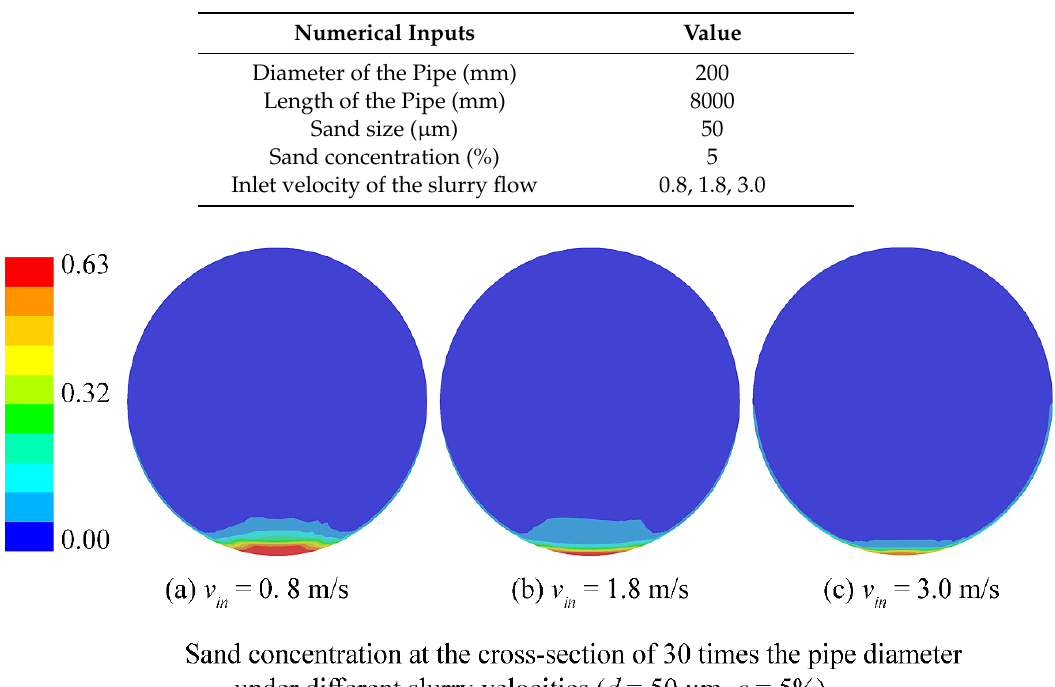
Table 5. Detailed inputs for the numerical simulation of sand transport and deposition under the condition of different inlet velocities of the slurry flow.